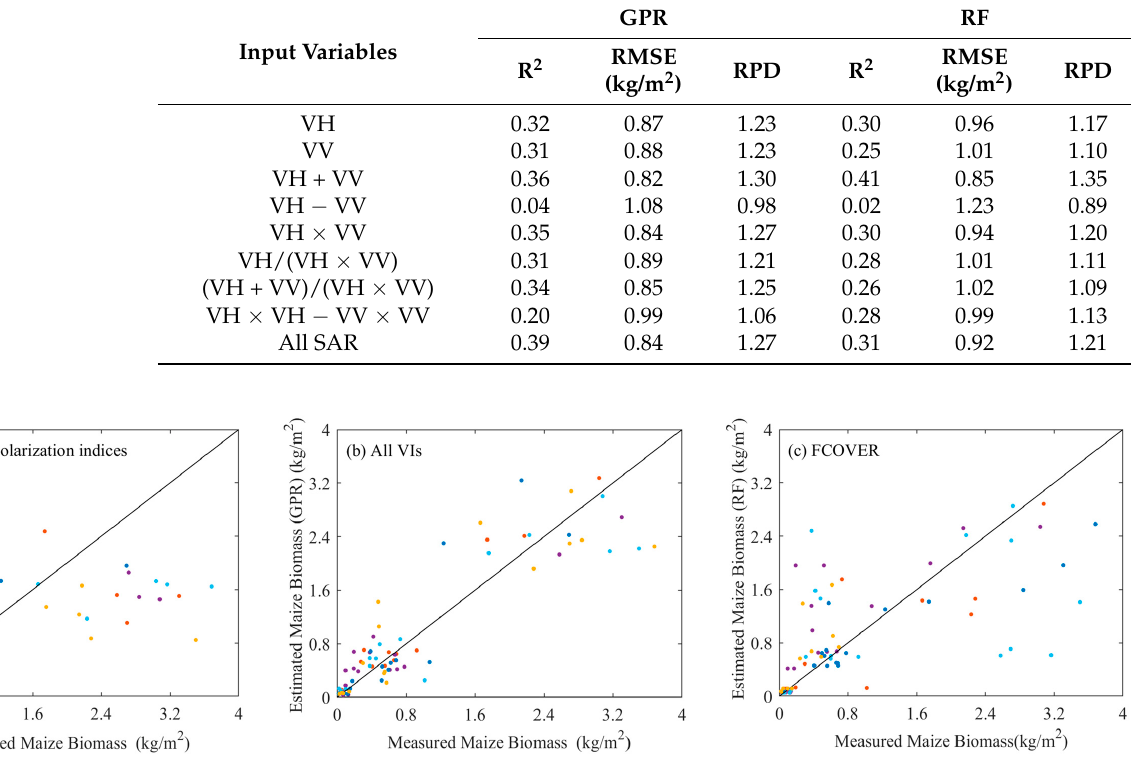
Figure 3. Measured vs. estimated biomass by the optimal models for each dataset ( a ) All SAR polarization indices with GPR, ( b ) all VIs with GPR, and (c) FCOVER with RF. The different colors indicated the 5-fold subsets.